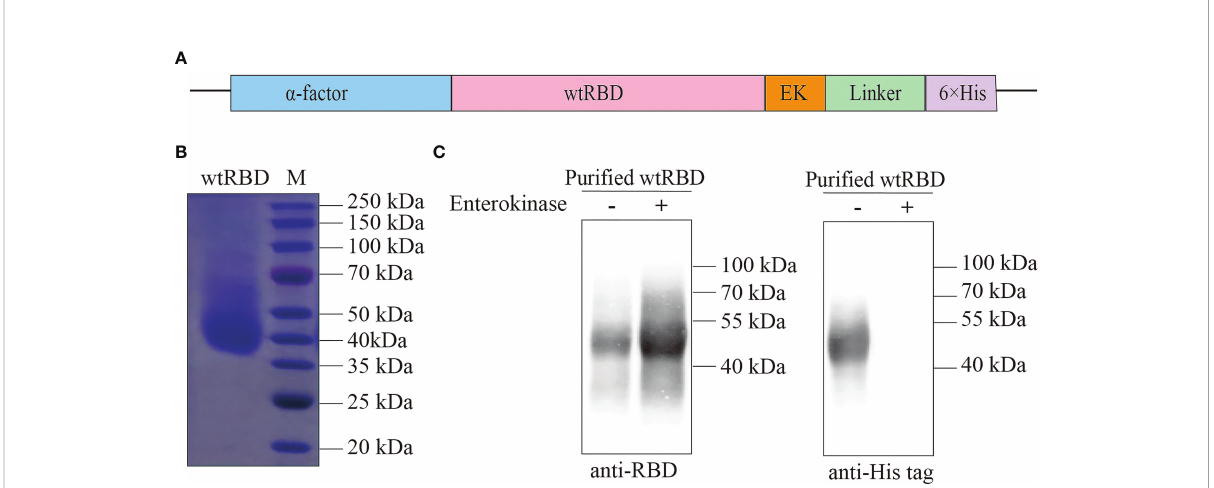
FIGURE 1 Puri fi cation of recombinant wtRBD protein from Pichia pastoris . (A) Schematic of the expression vector for the recombinant wtRBD protein expressed in yeast. wtRBD contained the a -factor signal peptide (blue) at the N terminus, and an Enterokinase (EK) cleavage site (orange) and a 6×His-tag (purple) at the C terminus. (B) The purity analysis of the puri fi ed recombinant wtRBD by Commassie blue staining. (C) Western blot analysis using SARS-CoV-2 RBD antibody (left) and 6×His antibody